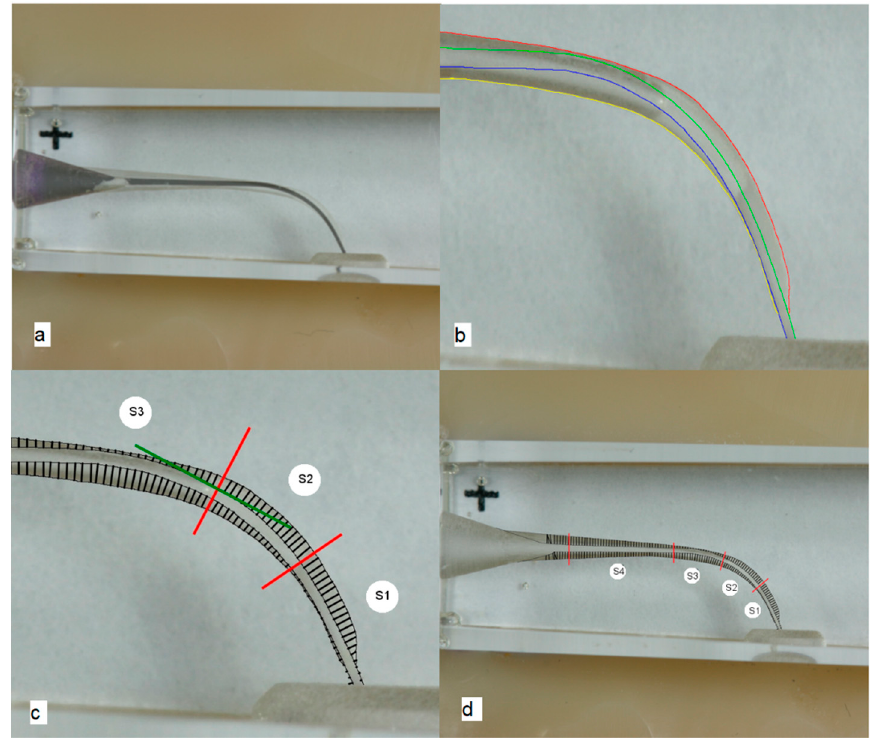
Figure 1. ( a ) Superimposed images of the unprepared and prepared canal. ( b ) Traced canal outlines. ( c ) Placement of tangents and measurement points placed. ( d ) Sections and measurement points placed over the complete canal.